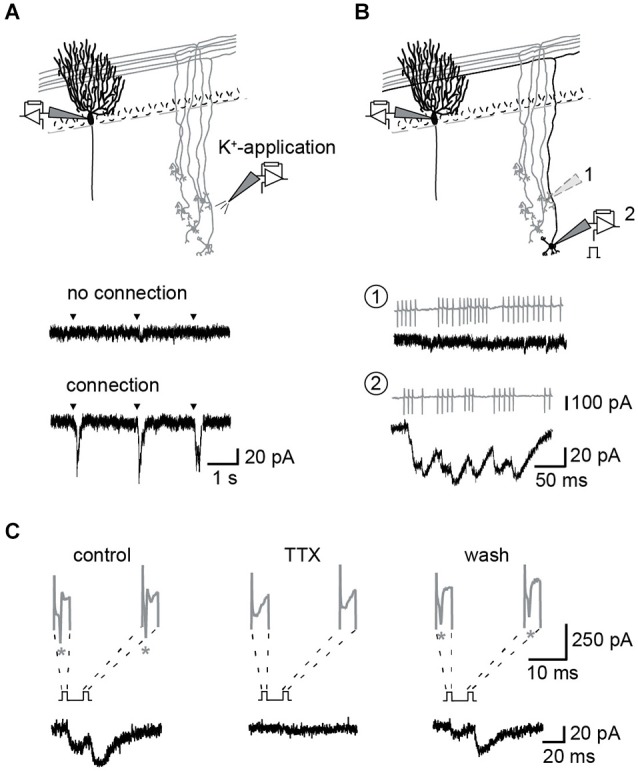
Identification of unitary GC–PN connections. (A,B) Schemes of experimental approaches. (A) Top: PNs were held in the whole-cell configuration. GCs were stimulated via puffs of K+-containing pipette solution applied to the granule cell layer (GCL). Example recordings from a PN during K+-application to different regions of the GCL are shown below. Middle: no activation of connected GCs; bottom: inward currents recorded in response to activation of connected GCs. Triangles indicate times of K+-application to the GLC. (B) Top: Single GCs were stimulated in the loose-cell attached configuration within the region that responded to K+-puffs. Bottom: Example recording from a not connected (1) and a connected (2) GC-PN pair. Action currents (ACs) (gray) elicited in the GC and the corresponding postsynaptic response (black). (C) Presynaptic ACs were reversibly inhibited by bath application of 1 μM TTX. Currents from GC (gray; stars denote ACs; initial peaks are capacitive currents) and the corresponding current traces (black) recorded from the connected PN.